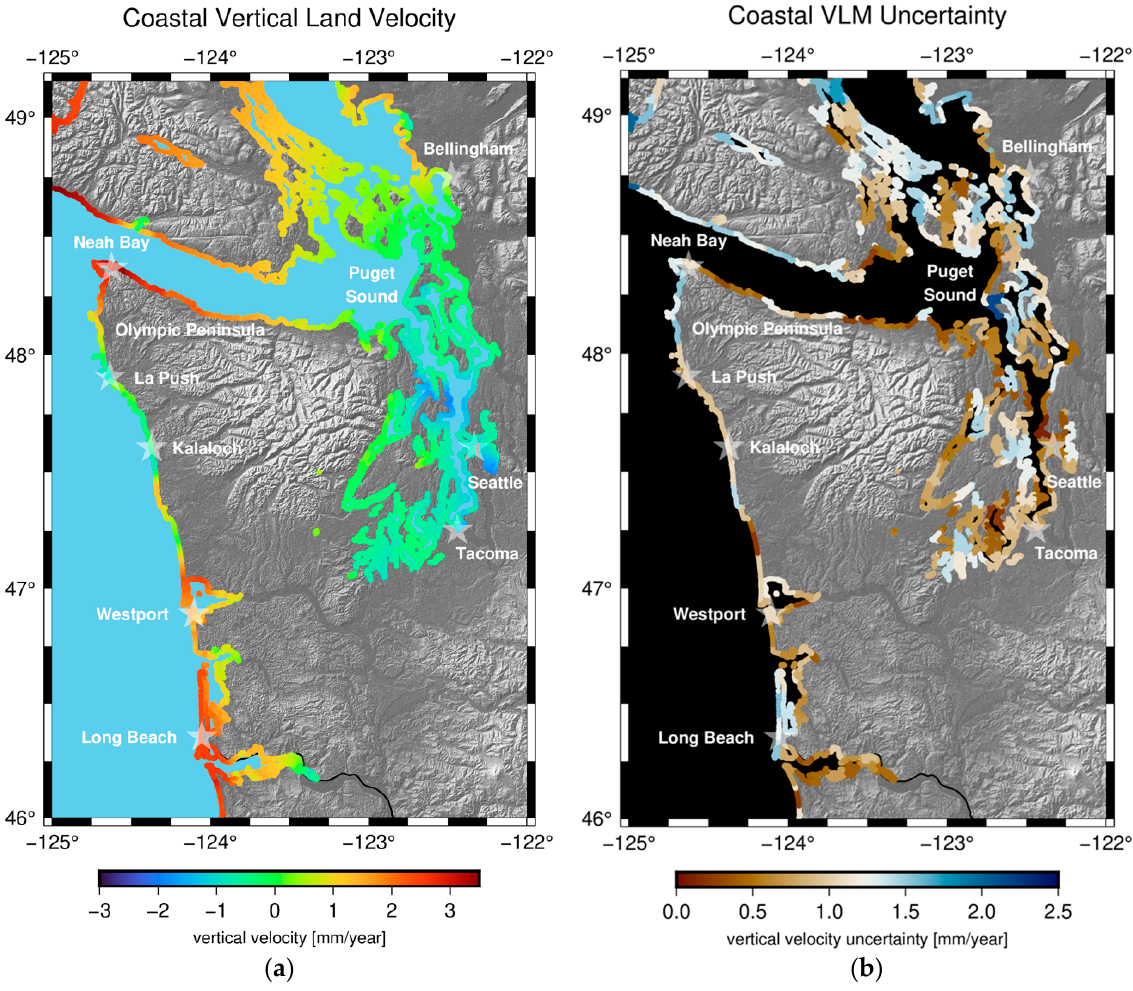
Figure 7. ( a ) Coastal vertical land movements along Washington’s coastline, derived from our interpolant, representing a continuous vertical velocity field for coastal Washington (Figure 5a). Select cities and towns marked by a star and their name in white. ( b ) Bootstrapped uncertainty of the interpolated vertical velocity field (as shown in Figure 5b) for coastal Washington.